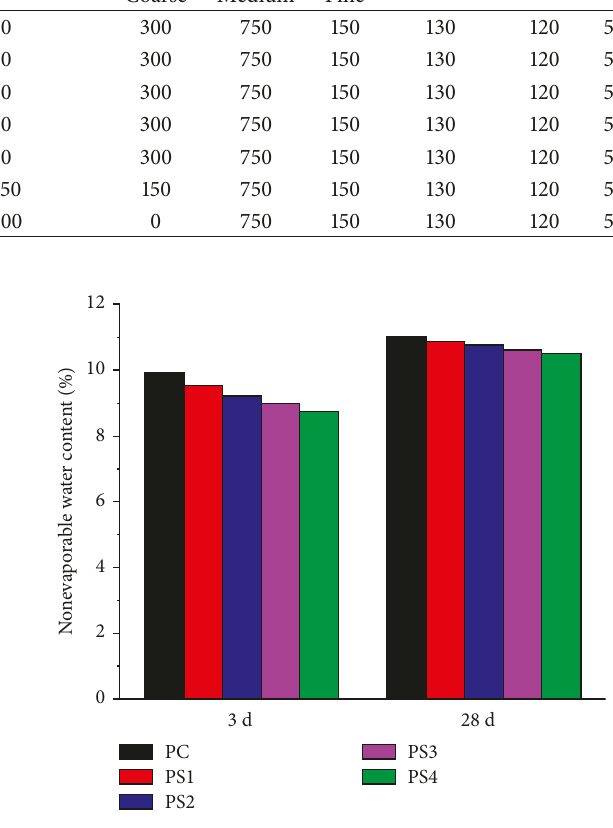
Figure 5: Nonevaporable water contents of hardened